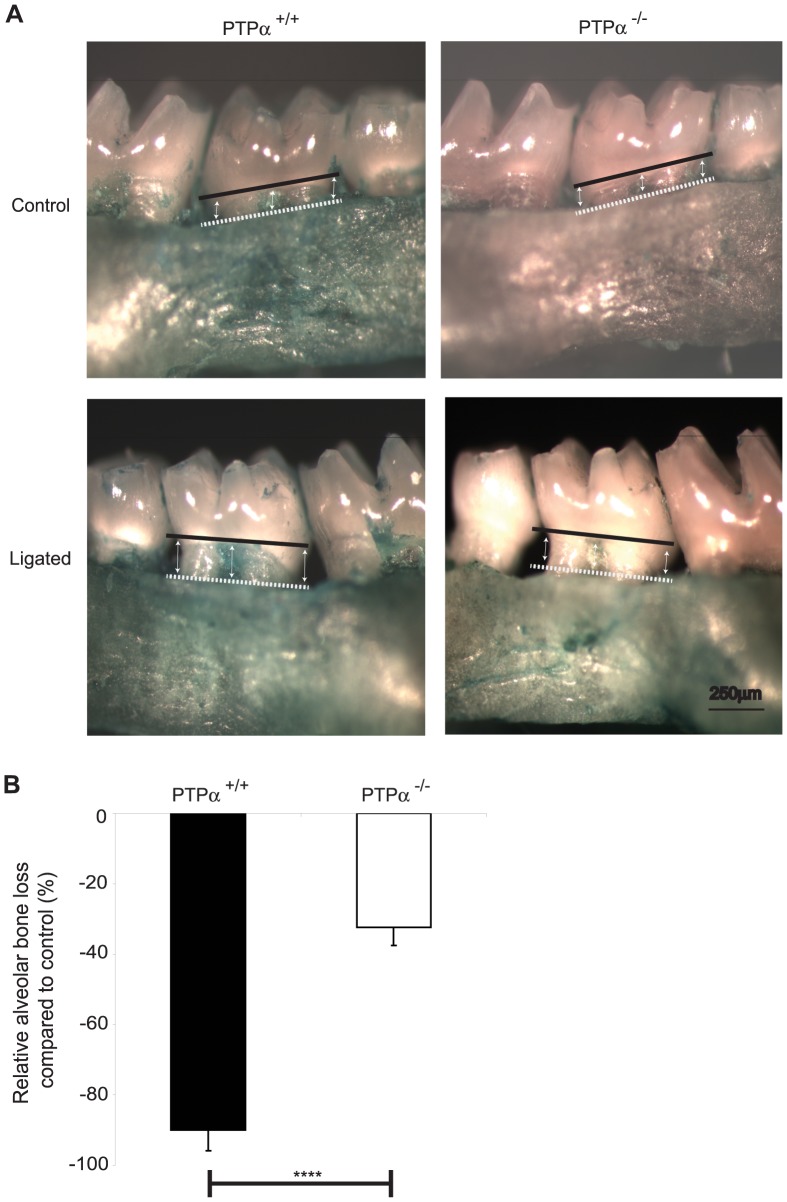
Bone loss analyzed by gross morphometry.(A) Maxilla were imaged with a stereomicroscope. The distance from CEJ (solid black line) to alveolar bone (dashed white line) was measured on ImageJ at mesial, mid and distal sites as indicated on the images, on both palatal and buccal sides. (B) The percent bone loss compared to the non-ligated side was plotted using the mean ± S.E.M. values from 5 maxillae per genotype. ****p<0.0001.